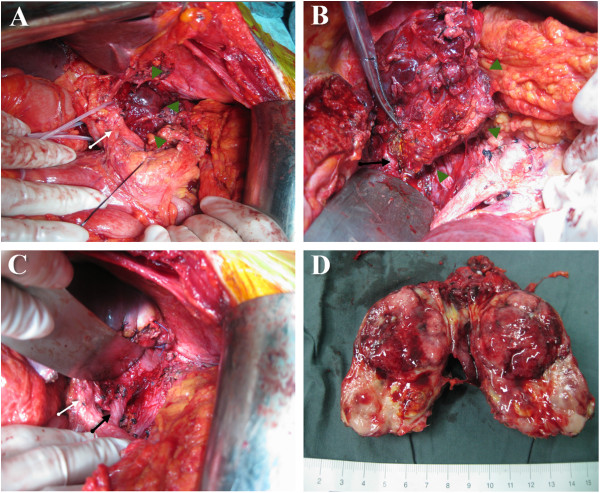
Intraoperative imaging of the retroperitoneal paraganglioma. (A) The tumor (indicated by arrowheads) was found behind the retrohepatic segment of the IVC with the hepatic hilum (indicated by an white arrow) lifted in an anterior direction. (B) After the gallbladder and the hepatic left lateral lobe were resected, the IVC (indicated by an black arrow) was carefully mobilized clockwise in a cephalad and dorsal direction up to the level of the second hepatic hilum via a left lateral side approach. (C) After the tumor was removed, the IVC (indicated by an black arrow) and the prevertebral space become fully visible. (D) Specimen of the retroperitoneal paraganglioma.